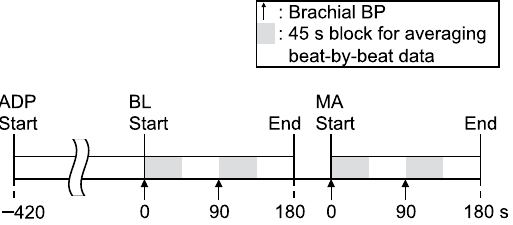
Figure 3. Experimental procedure. After 7-min adaptation (ADP), 3-min baseline (BL) was followed by 3-min mental arithmetic (MA) period. Arrows represent the start of each measurement using the brachial cuff sphygmomanometer. Each halftone screening period represents a 45-s block for averaging the beat-by-beat